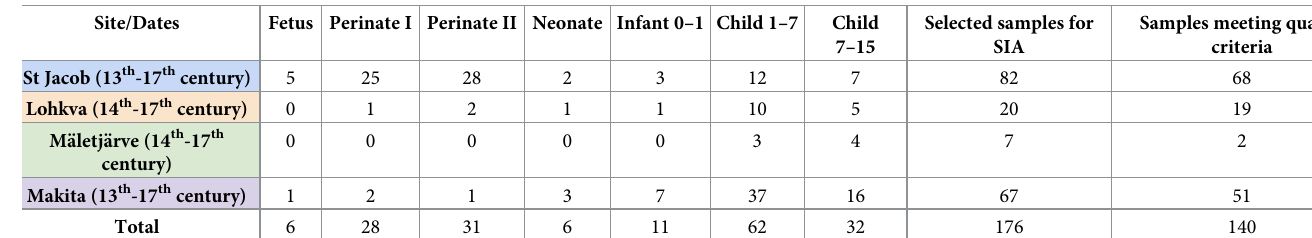
Table 1. Assemblage of this